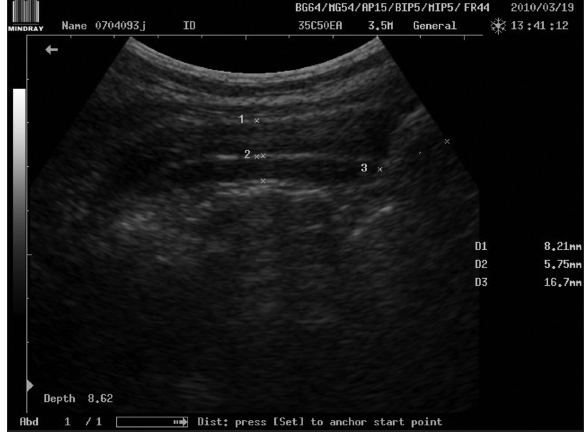
Figure 4: Contraction of the Abdominal Wall For preferential activation of the TrA, an isolated contraction of the TrA was expected. The increase in depth and lateral corseting were noted as the TrA slides under the OI and increases tension in the anterior TrA fascia. An increase was noted during contraction. The measurement of OI was 8.21mm, for TrA was 5.75mm and the TrA pull